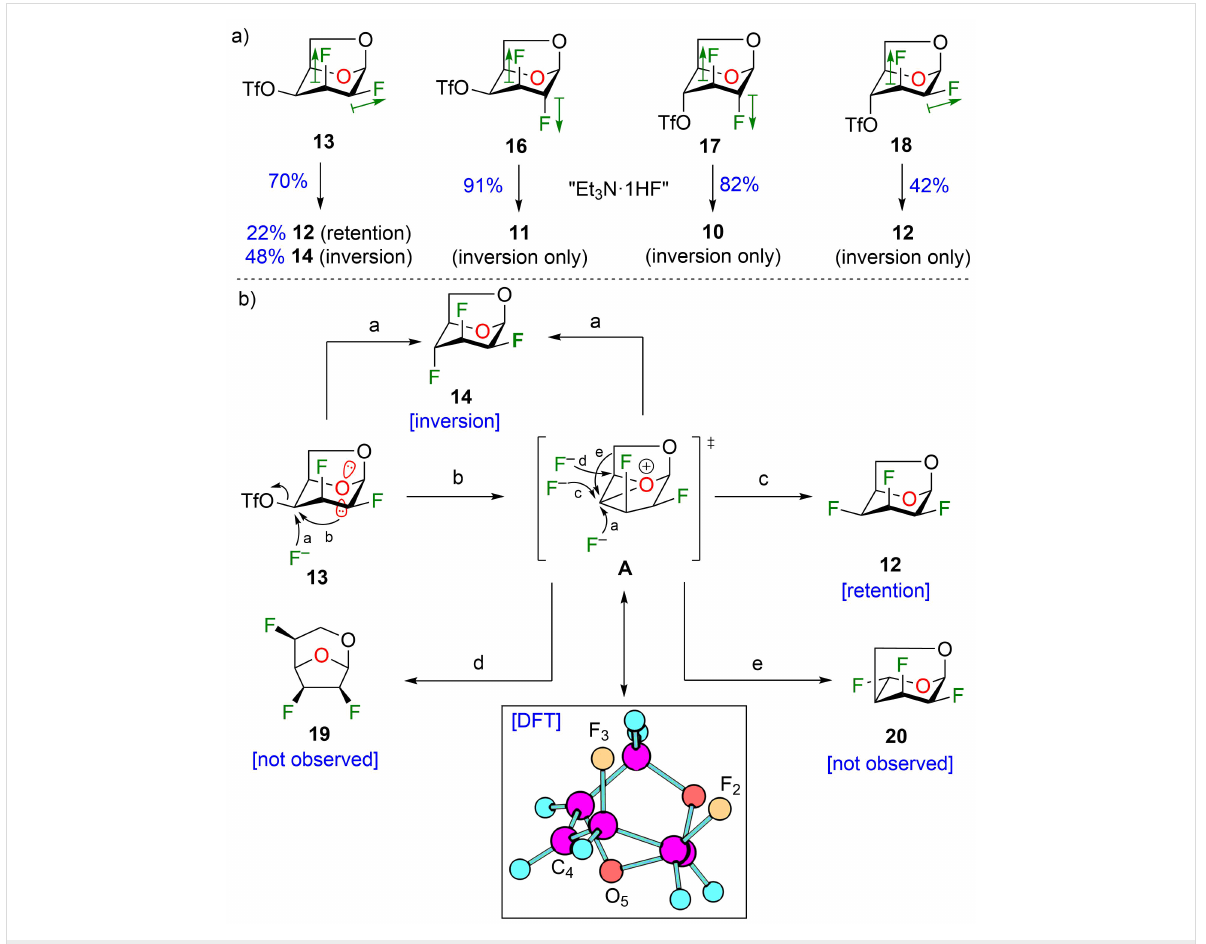
Figure 3: Fluorination at C4 of 1,6-anhydro-2,3-difluorohexopyranose analogues. a) Reactions on triflates 13 , 16–18 , dipole of C–F bonds are displayed in green arrows; b) Proposed mechanism for the formation of trifluorotalose analogue 12 and trifluoromannose analogue 14 via an oxira- nium-like intermediate A from compound 13